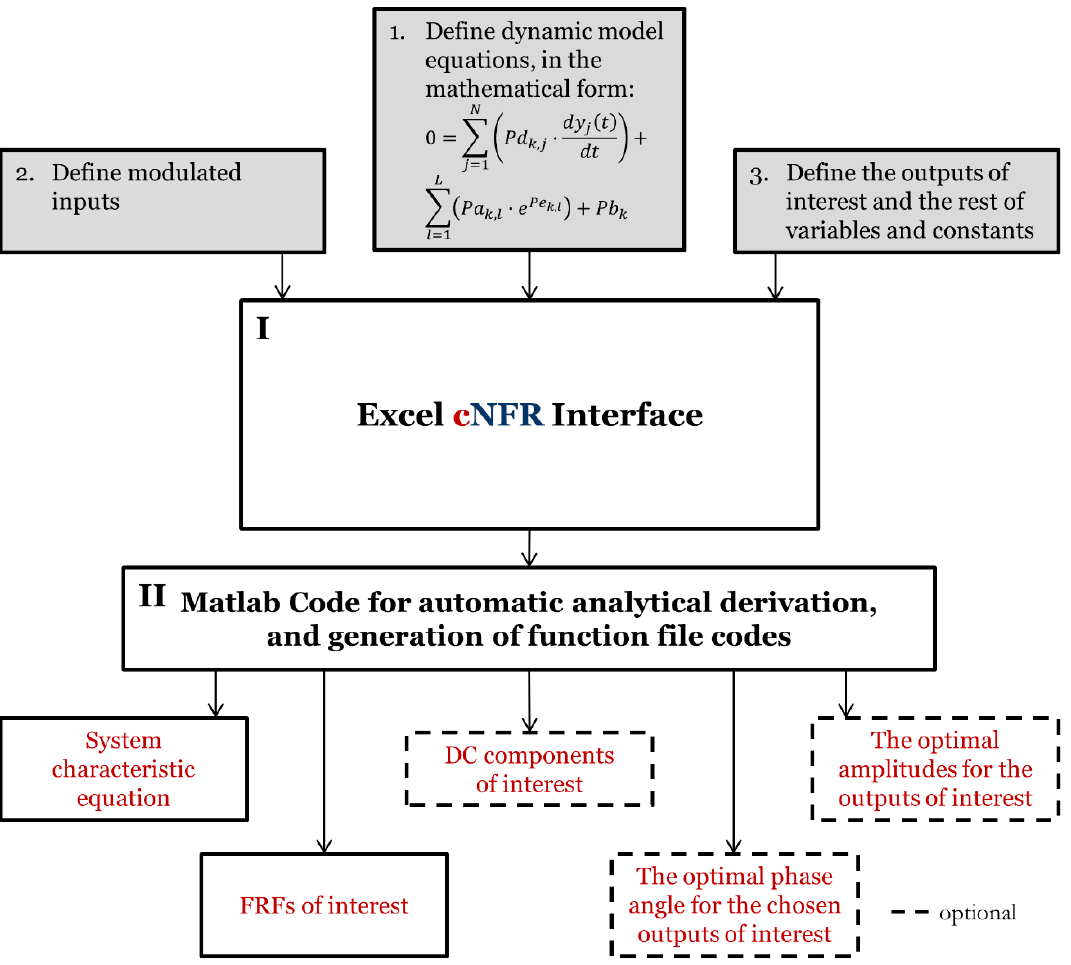
Figure 3. The cNFR routine with the user-required steps (gray rectangles) and steps automatically done by the application (white rectangles).